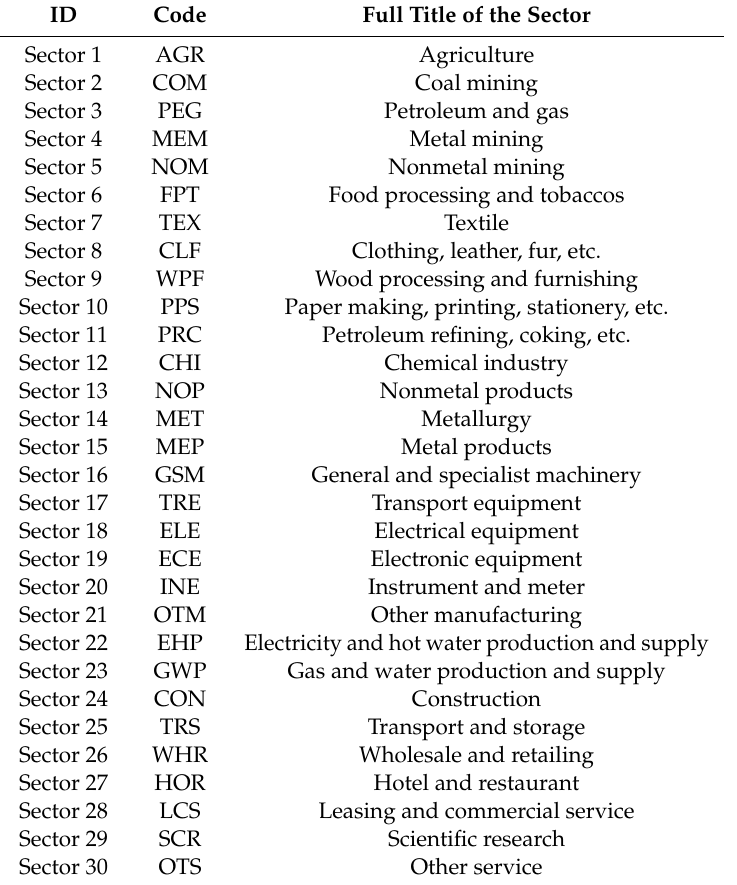
Table 1. Codes for sectors.